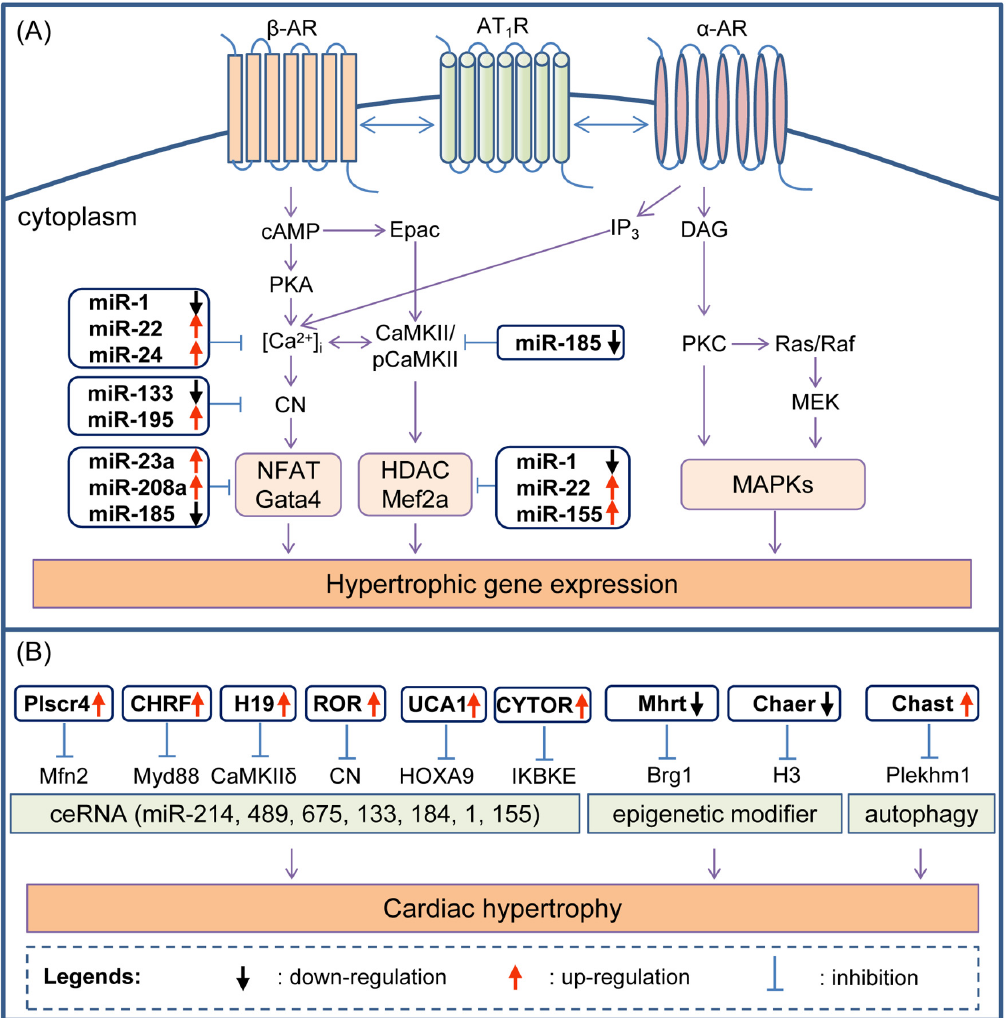
Figure 2. Interaction of partial ncRNAs in cardiac hypertrophy and heart failure. ( A ) MiRNAs regulate hypertrophic Ca 2+ signaling pathway; ( B ) lncRNAs exert splicing regulation and translational regulation through competing endogenous RNA (ceRNA) mechanism. β -AR, β -adrenoceptors; AT1R, angiotensin Ⅱ type-1 receptor; α -AR, alpha-adrenergic receptor; cAMP, cyclic adenosine monophosphate; PKA, activates protein kinase A; [Ca 2+ ]i, intracellular Ca 2+ concentration; CN, calcineurin; NFAT, nuclear factor of activated T cells; Gata4, GATA-binding factor 4; Epac, exchange factor directly activated by cAMP; CaMKII, calmodulin dependent kinase II; pCaMKII, the phosphorylation of CaMKII; HDAC, histone deacetylase; Mef2a, myocyte-specific enhancer factor 2A; IP3, inositol 1, 4, 5-trisphosphate; DAG, dystrophin-associated glycoprotein; PKC, protein kinase C; Ras, Ras family of small GTPases; Raf, Raf proto-oncogene serine/threonine-protein kinase; MEK, mitogen-activated extracellular signal-regulated kinase; MAPKs, mitogen-activated protein kinases; Mfn2, mitofusin-2; Myd88, myeloid differentiation primary response gene 88; CaMKII δ , calmodulin dependent kinase II δ ; HOXA9, homeobox A9; IKBKE, I-kappa-B kinase epsilon; H3, histone H3; Plekhm1, Pleckstrin homology domain-containing protein family M member